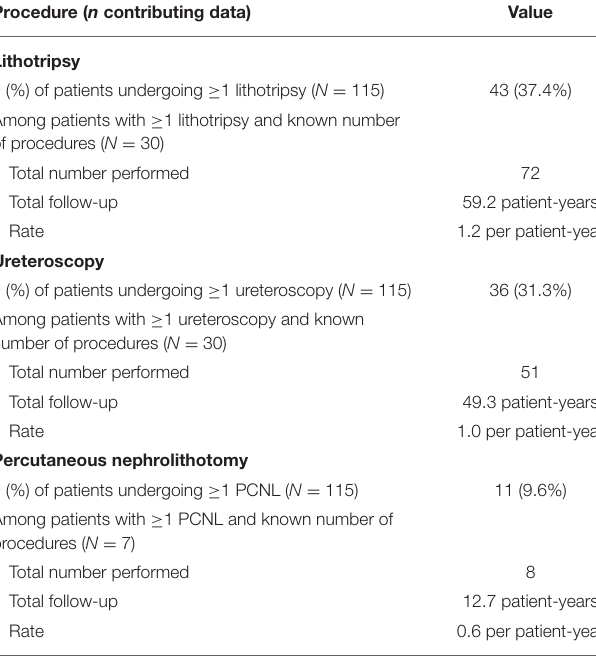
TABLE 5 | PH1-related medical procedures during